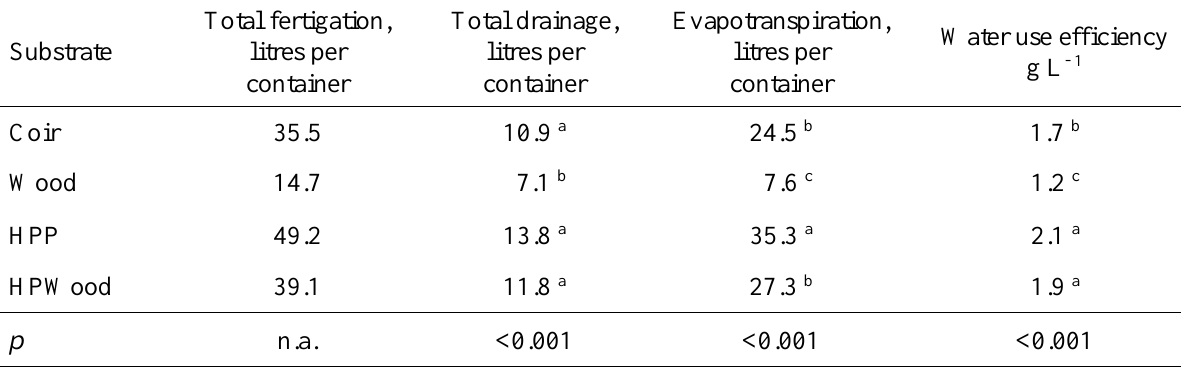
Table 2. Total fertigation volume, estimated drainage, evapotranspiration per container, and mean water use grown in different substrates in plant towers. Different superscripts indicate statistically significant differences between the means within each factor by Tukey’s test (P <0.05). n.a. = not